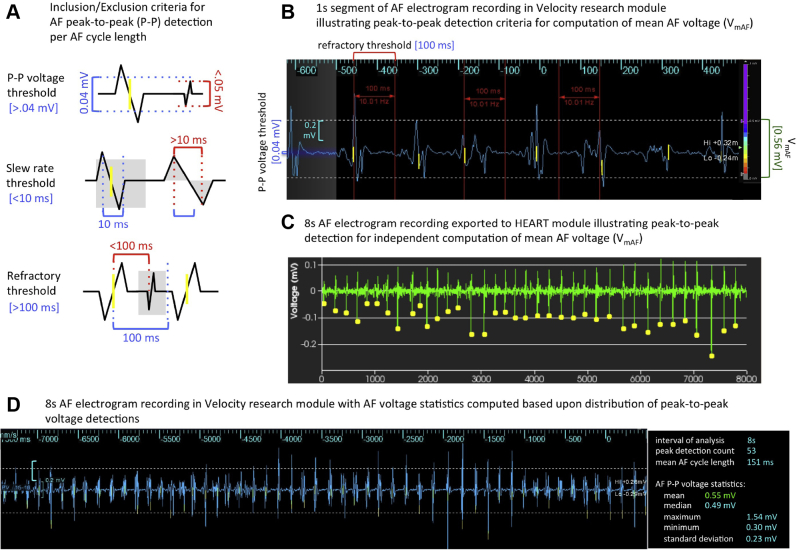
Criteria for determination of mean AF voltage (VmAF). A: Inclusion/exclusion criteria for AF peak-to-peak detection per AF cycle length. B: AF electrogram (1 second) illustrating implementation of P-P detection criteria in the Velocity research module. C: AF electrogram (8 seconds) from the HEART software module. D: AF electrogram (8 seconds) from the Velocity research module. AF voltage statistics are computed based on the distribution of all peak-to-peak voltage detections (right).